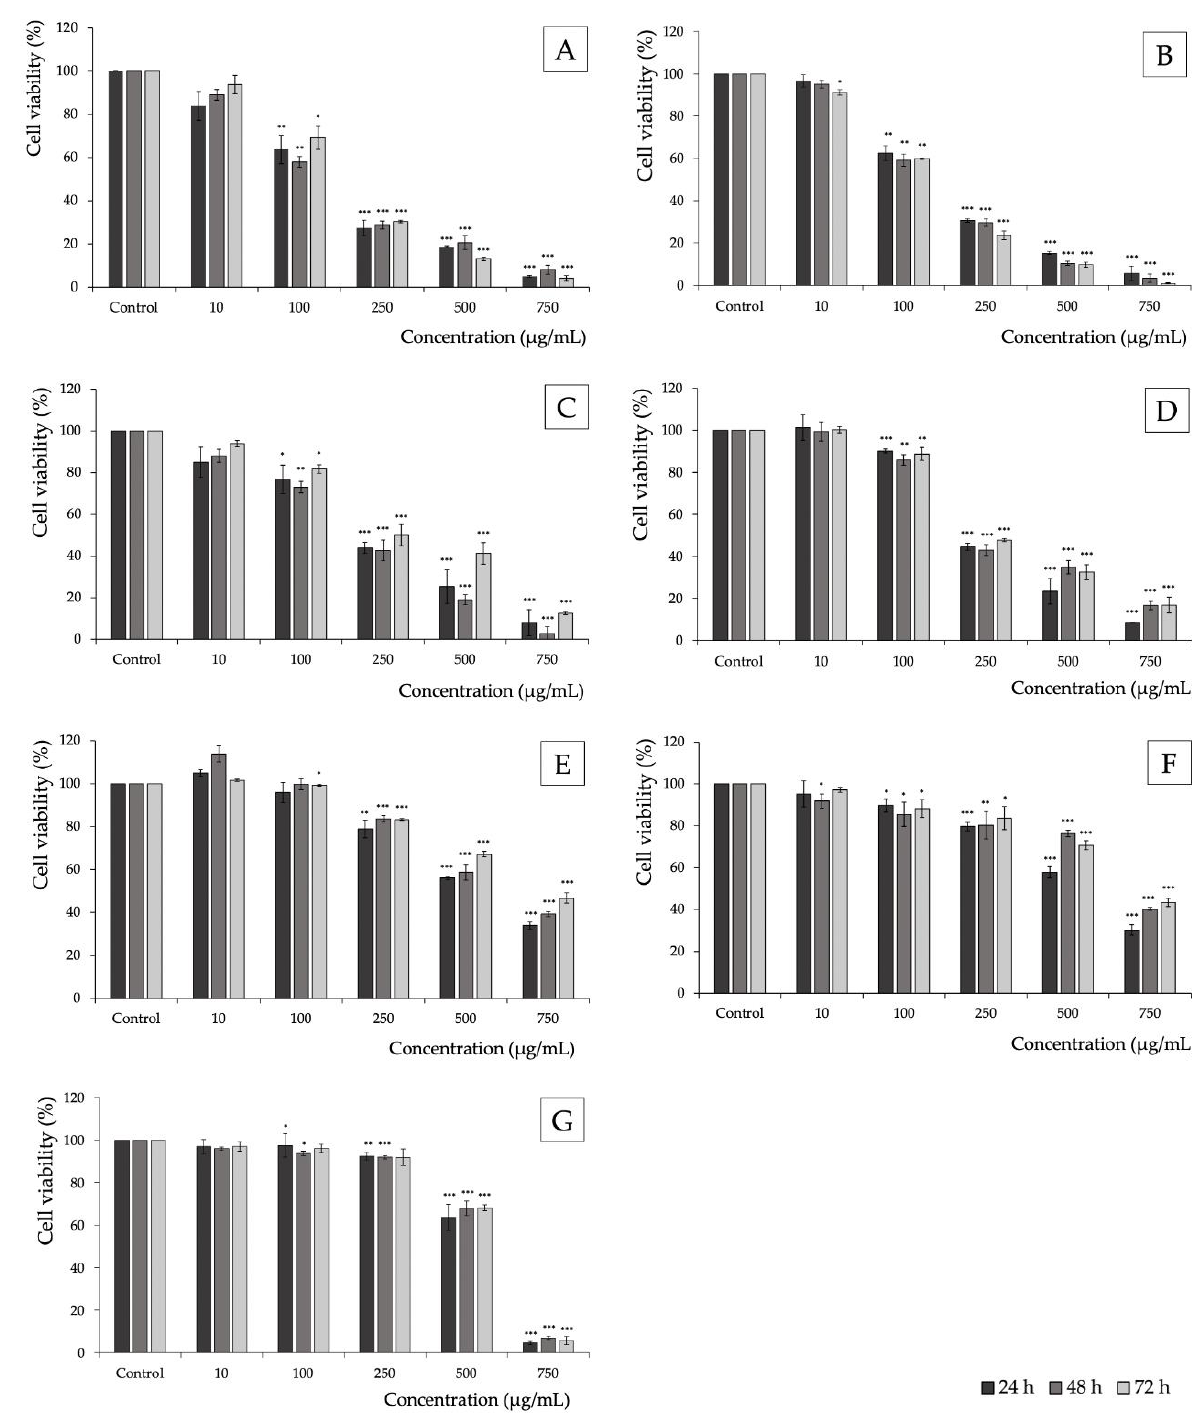
Figure 1. Cytotoxic effect of J. regia pollen extract on MCF-7 ( A ), DLD-1 ( B ), Caco-2 ( C ), U87MG ( D ), U251MG ( E ), SK-Mel-29 ( F ), and CCD841 CoN ( G ) cell lines. All cells were treated for 24, 48, and 72 h (black, gray-black, and black bars, respectively). The number of viable control (non-treated) cells at each time point served as 100% viability. Graphs represent mean values ± SD. The significance of the differences was determined by Student’s t -test. * p < 0.05, ** p < 0.01, *** p < 0.001.